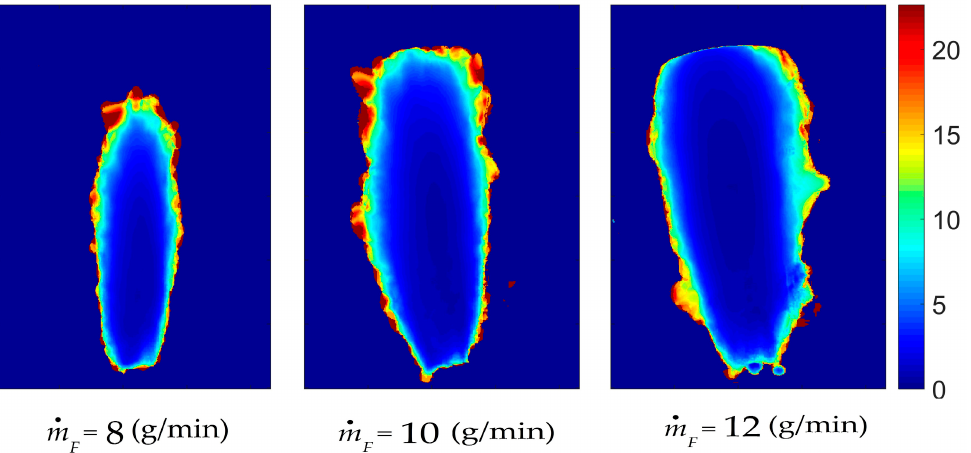
Figure 6. The distribution of coefficient of variation for the mass flow rate of fuel.